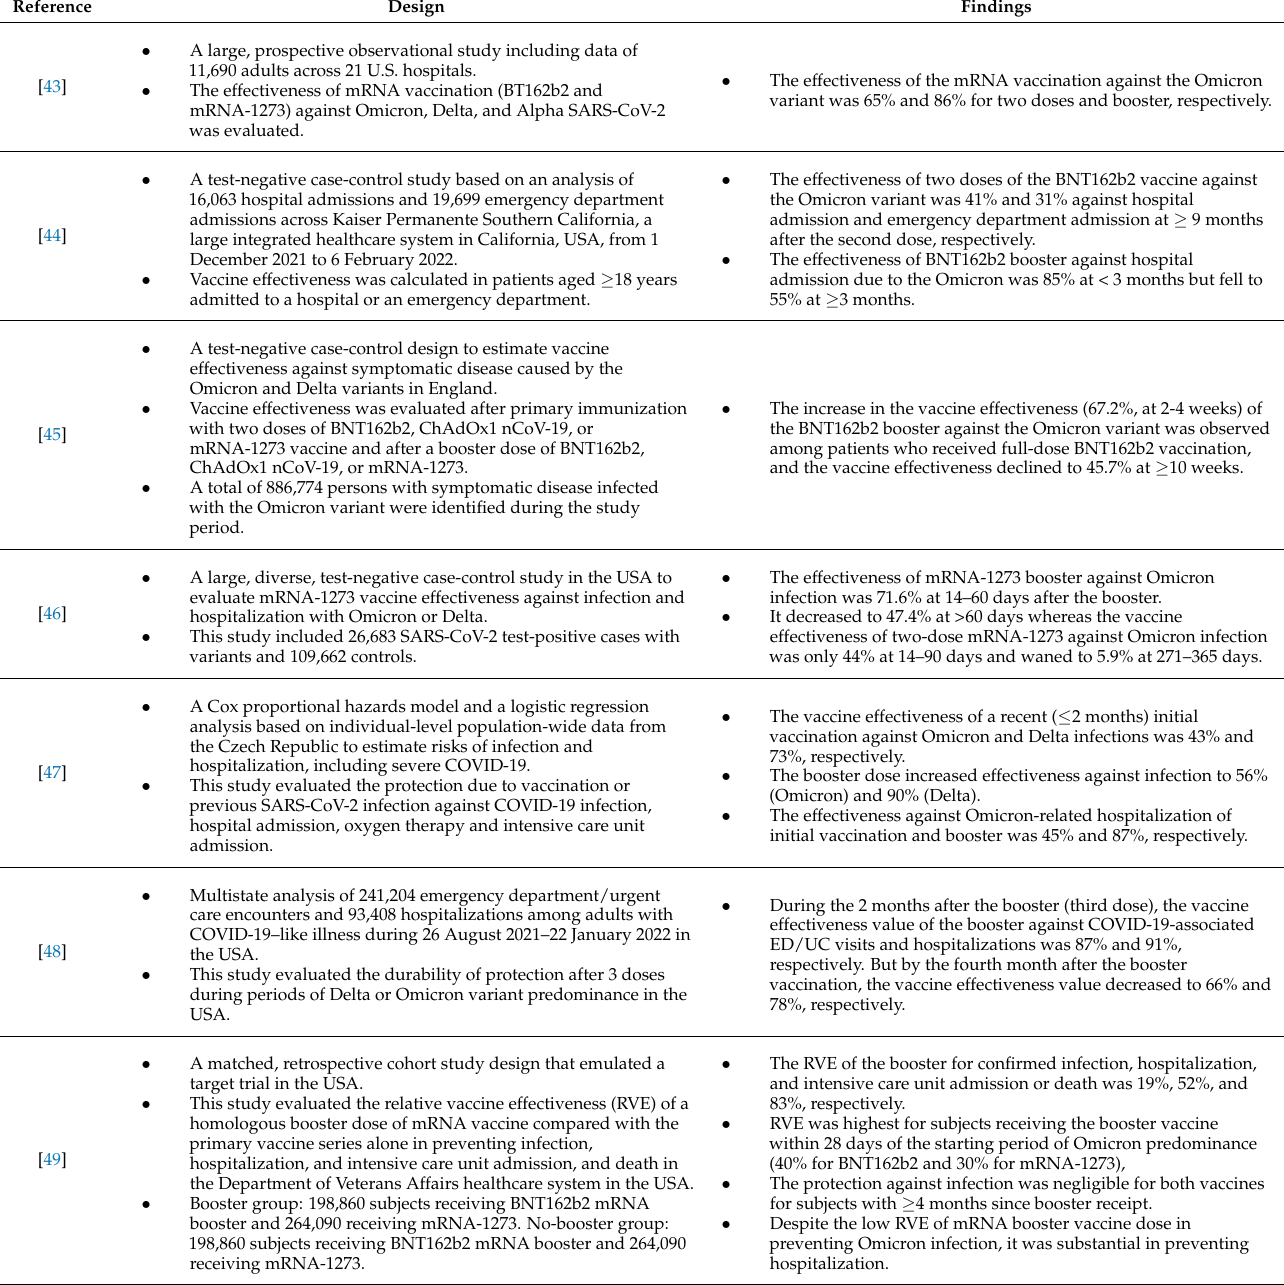
Table 2. Summary of studies evaluating the effectiveness of the first COVID-19 vaccine booster against the Omicron